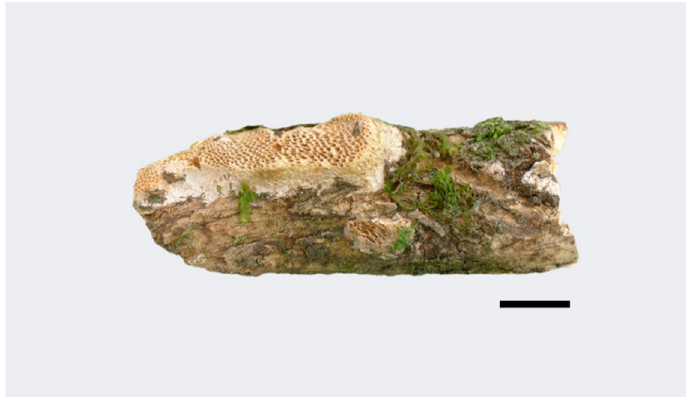
Figure 5. Basidiocarp of Haploporus longisporus (Holotype). Scale bar = 1.0 cm.